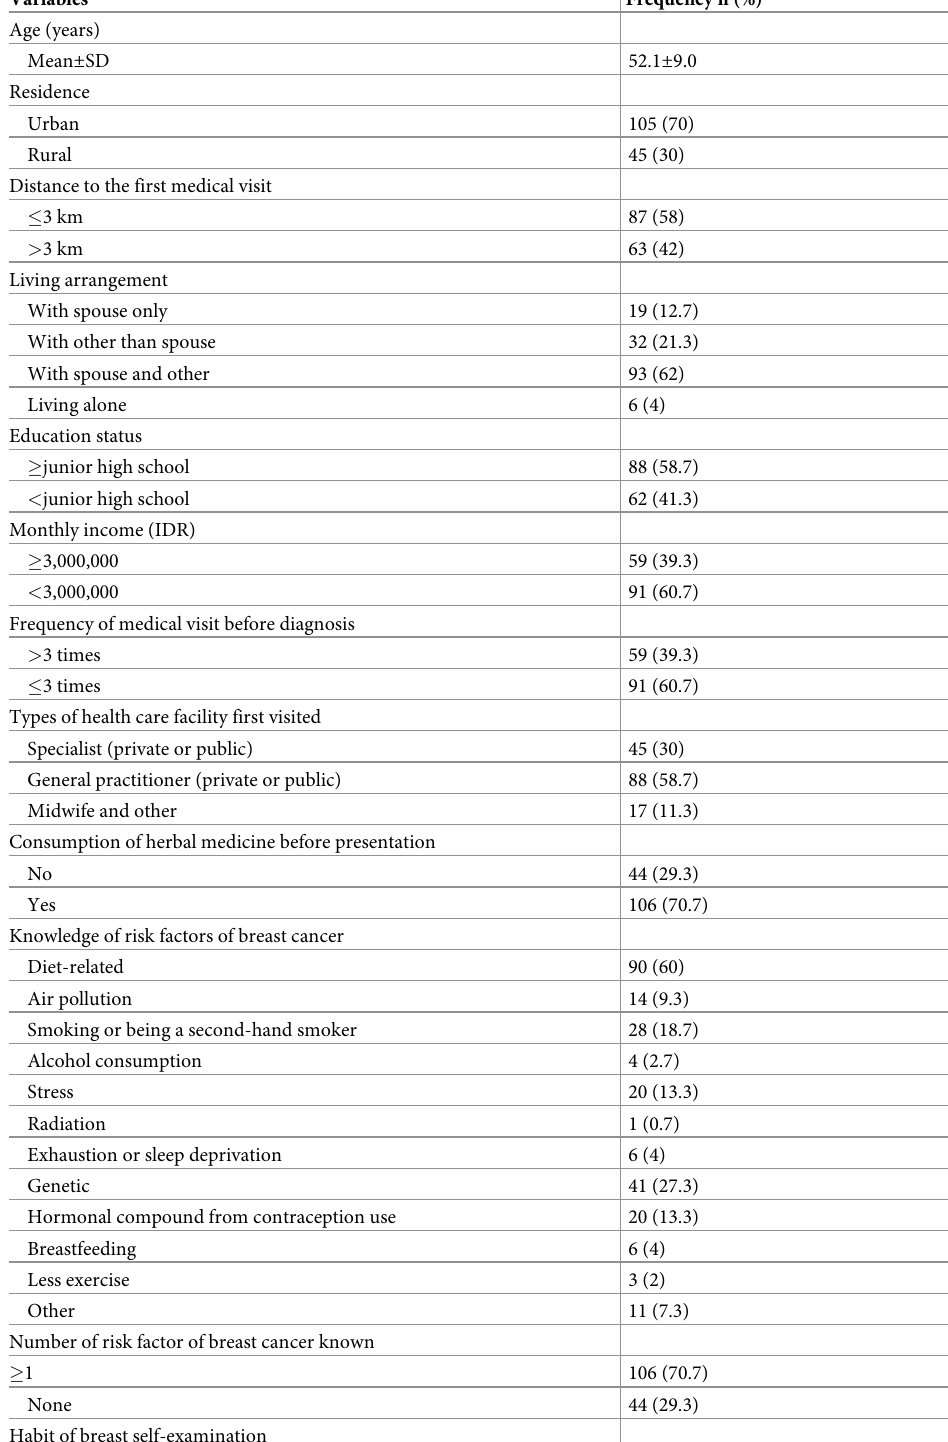
Table 1. Sociodemographic, clinical, and delay characteristics of study participants (n = 150) recruited from Dr. Sardjito Hospital, Yogyakarta in